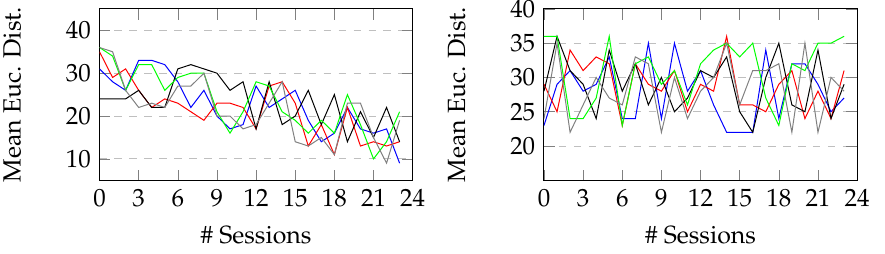
Figure 6. Evolution of the copy pose activity at ADACEA ( left ) and at the nursing home ( right ).